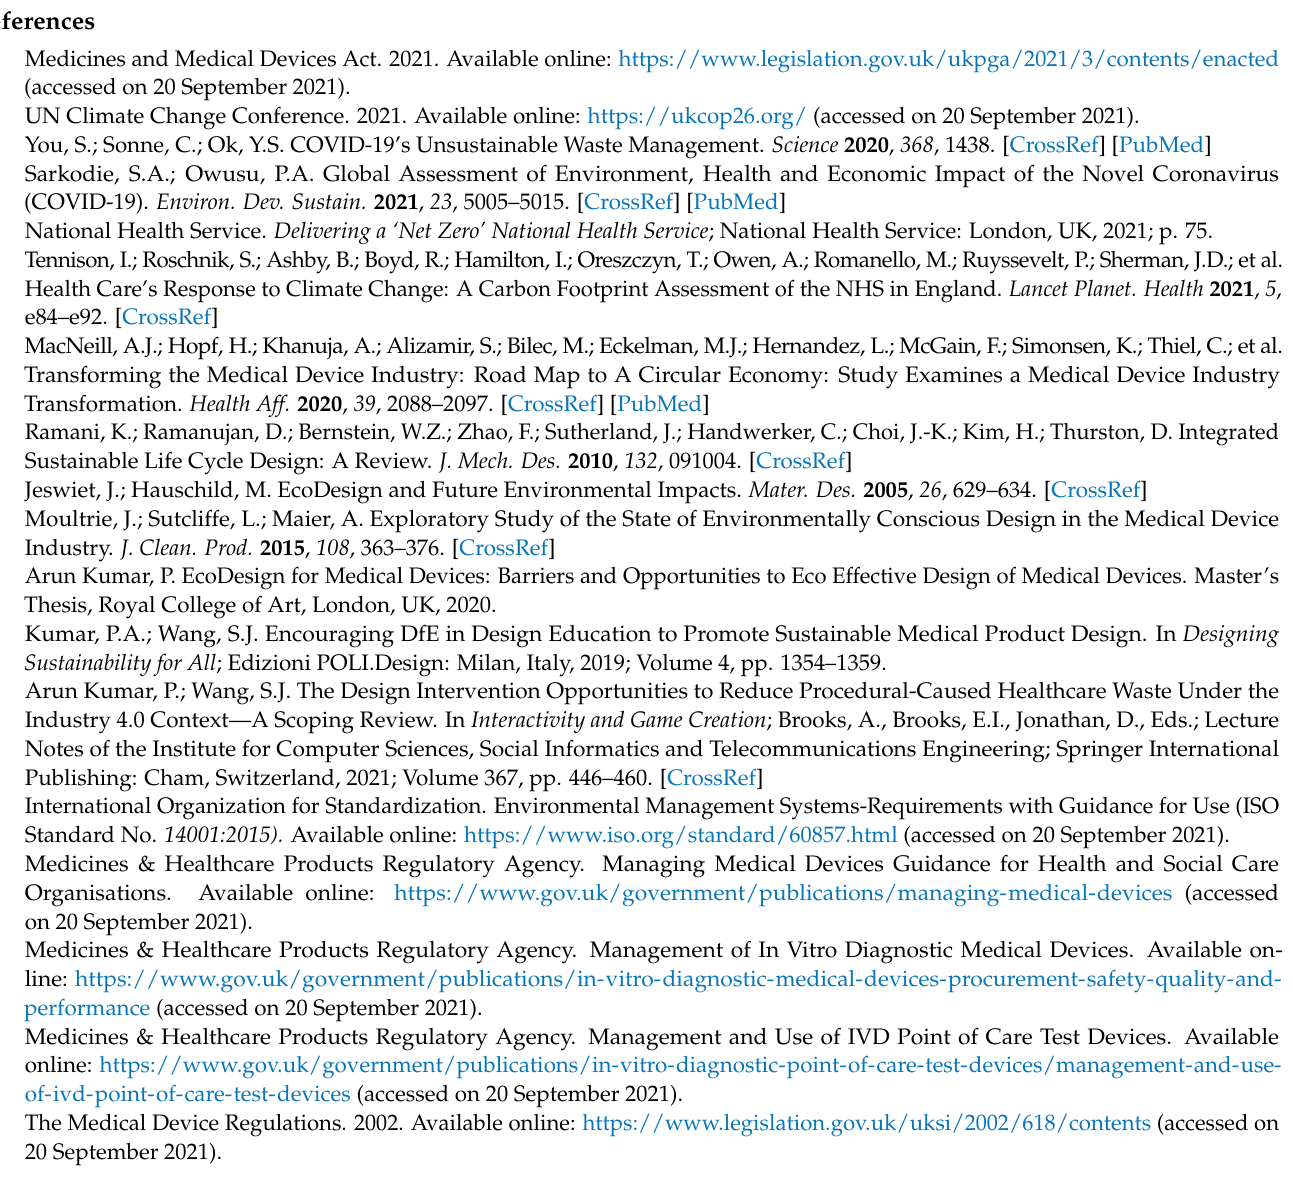
The waste segregation chart not only delineates the segregation process but also provides the disposal options. The disposal options for each waste type have been provided in Table 1. Majority of the disposal strategies suggest cradle-to-grave lifecycles, with very few recovery strategies offered for different types of waste streams.